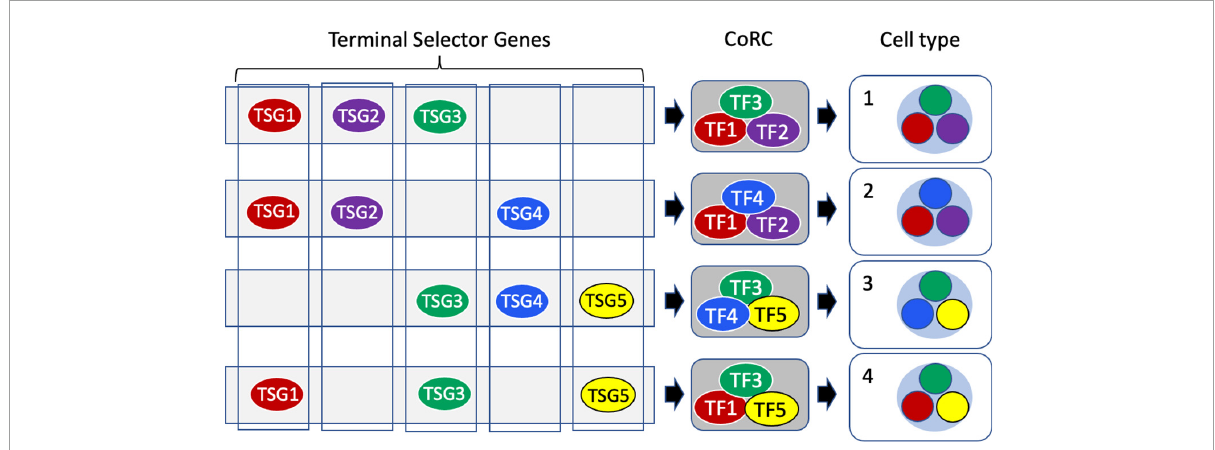
FIGURE6 Terminal selectors, core regulatory complexes and cell type determination. Terminal Selector Genes (TSGs) encode transcription factors (TFs) each of which controls the expression of a suite of downstream effector genes. Terminal selector TF proteins act combinatorially, assembled into Core Regulatory Complexes (CoRCs) that also include accessory proteins. At the cell level, the different TFs of the CoRC each direct the transcription of their effector genes to produce a distinctive overall transcriptome characteristic of a specific cell type (nucleus shown as a light blue circle, with the sub-transcriptomes comprising expression of effectors color-coded to reflect the terminal selector TF regulating their